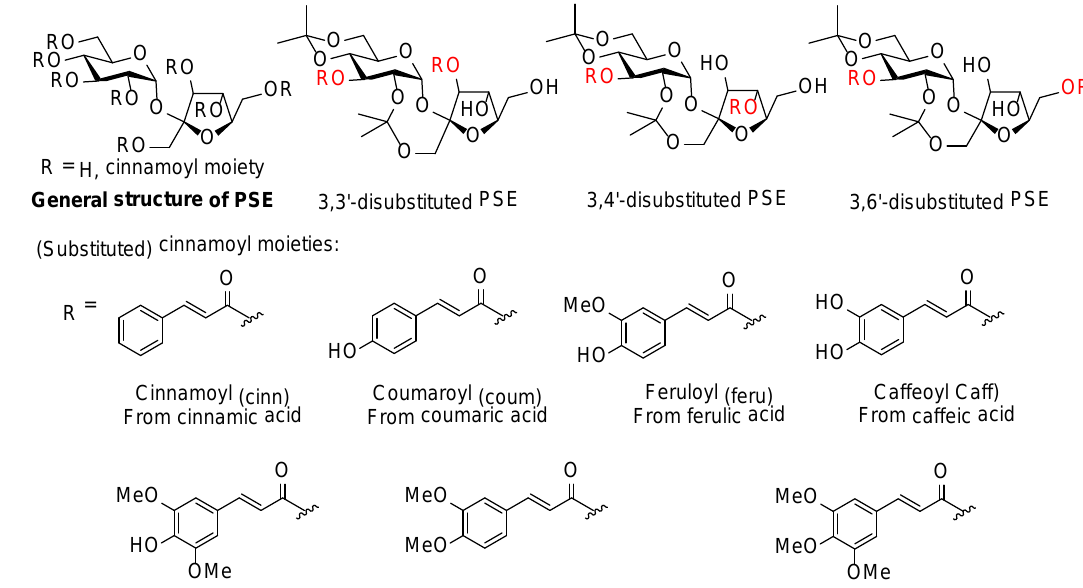
Figure 1. General structure of PSE and the targeted 3, 3′ -, 3, 4′ -, and 3, 6′ -di-substituted